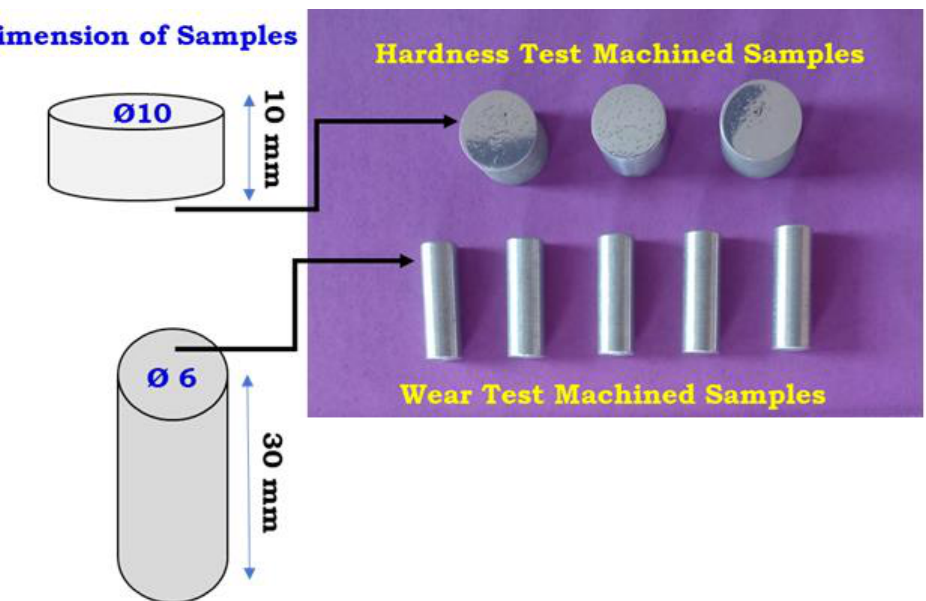
Figure 4. Details of dimensions of wear rate and hardness of stir cast composite samples.